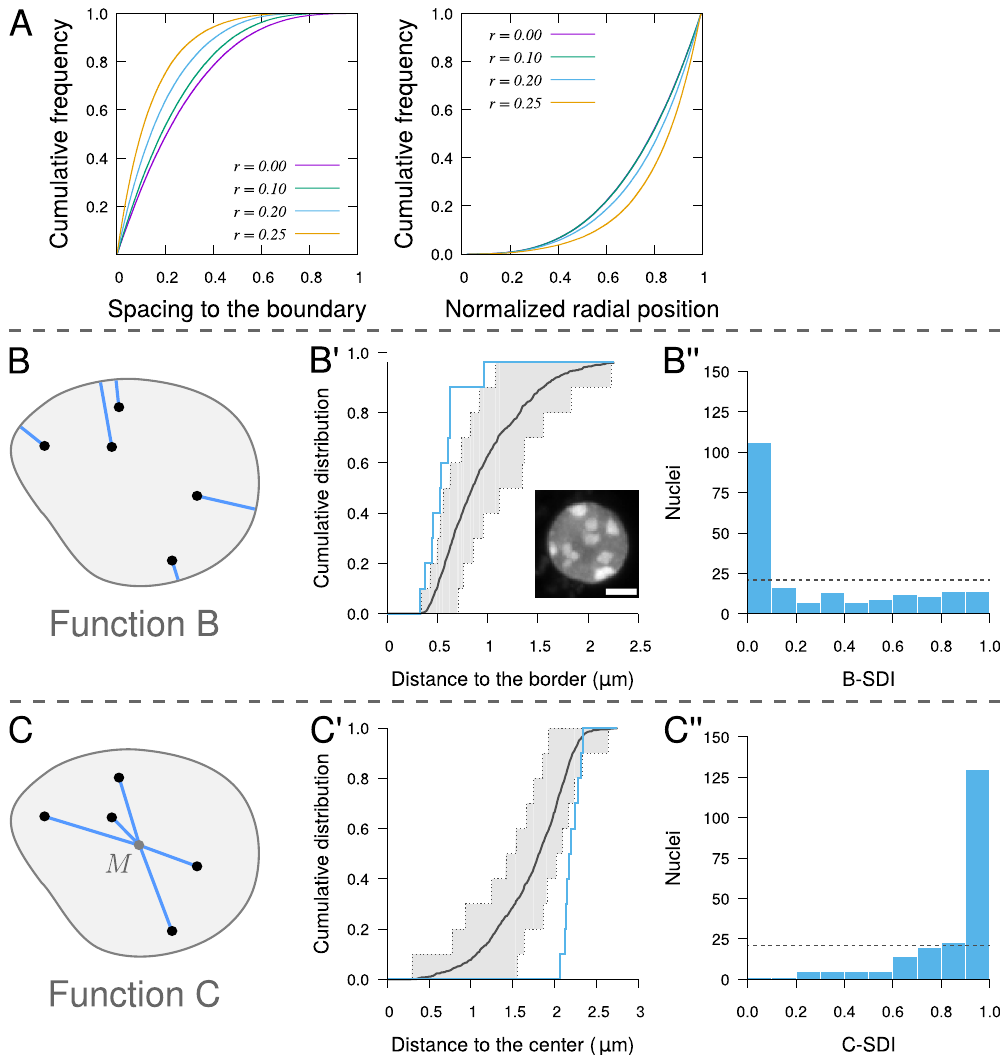
Figure 3. Testing spatial interactions between objects and domain boundary with application to the peripheral positioning of chromocenters in A. thaliana cell nuclei. ( A ) Radial positioning of spherical objects uniformly distributed at random within a unit sphere (averages over 10,000 simulated patterns containing 10 objects of radius r ). Left : spacing between objects and sphere boundary. Right : distance to sphere center following normalization of maximum distances to 1. ( B ) Distance measurement between object centroid and its closest point on domain boundary used for function B . Same notations as in Fig. 2. ( B ′ ) Function B ( Blue ) measured in a sample nucleus ( Inset ; scale bar: 2 µ m). Black and Grey : average function and 95% envelope, respectively, under the completely random model. ( B” ) Distribution of the SDI computed using function B in the population of nuclei. Dotted line : distribution expected under a random organization. ( C ) Distance measurement between object and domain centroids used for function C . M : domain centroid. ( C ′ , C” ) Same as ( B ′ , B” ) with